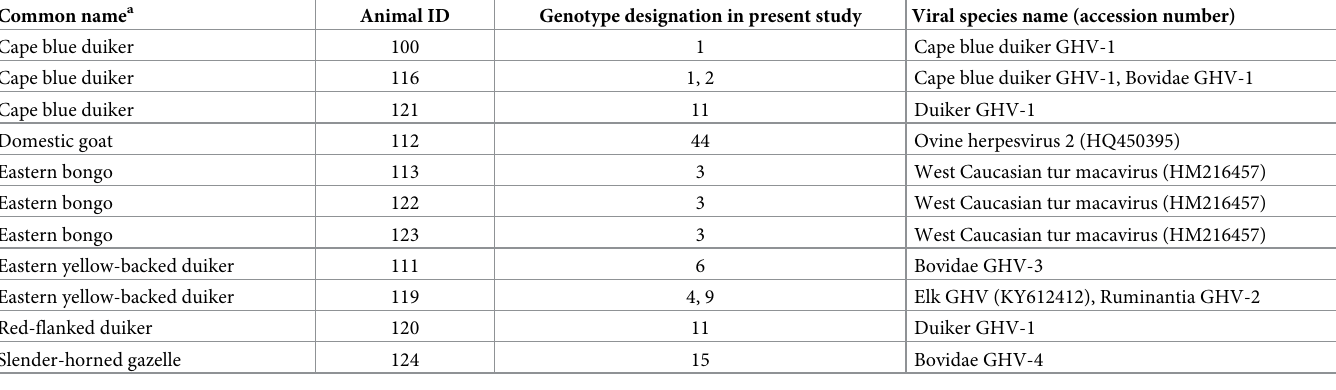
Table 4. Summary of PCR and sequencing results from individual animals with clinical signs of